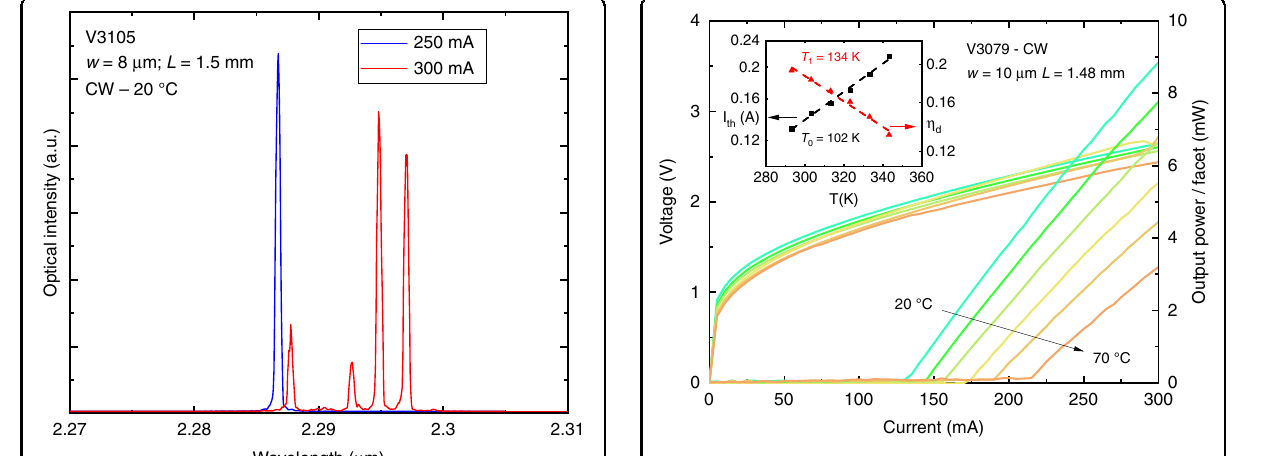
Fig. 8 L – I – V curves in CW at various temperatures for a GaSb DL grown on a MOVPE GaAs-on-Si template. The inset shows the evolution of the current threshold and the external quantum ef fi ciency as a function of the temperature. Adapted with permission from ref. 107 . © Optical Society of America